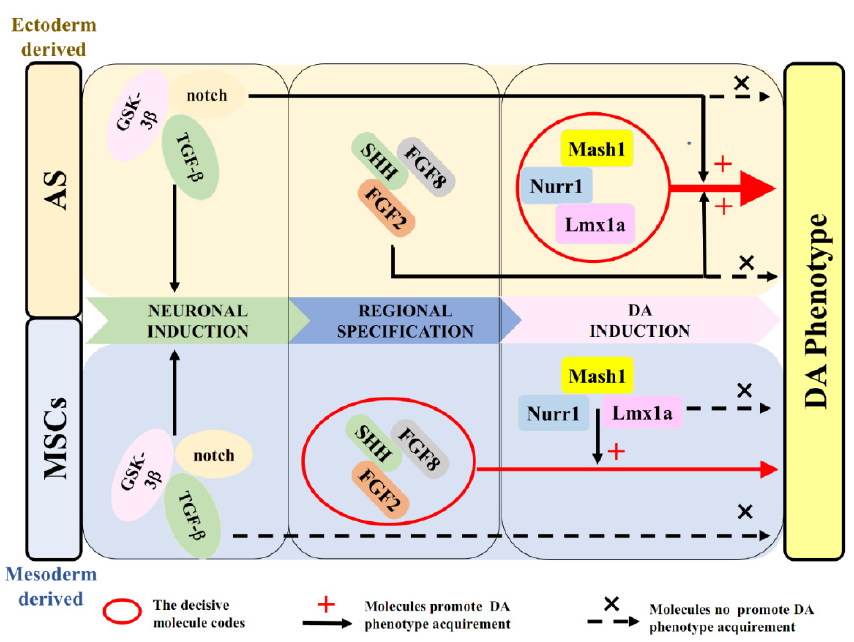
Figure 7. The differential decisive molecular code governing the DA phenotype acquirement of AS vs. MSCs. The diagram summarizes the sequential stages and possible key molecules involved in DA phenotype development from ectoderm- (AS) and mesoderm-derived (MSC) cells, respectively. Transcriptional regulation with Mash1, Nurr1, Lmx1a (MLN) plays a dominant role in the determi- nation of DA phenotype from AS; small molecules involved in TGF- β , GSK-3 β , and Notch pathways (SB431542, CHIR99021, and DAPT; S/C/D), as well as morphogens SHH, FGF2 and FGF8 (S/F8/F2), accelerate the efficiency of DA induction. In contrast, morphogens S/F8/F2 involved in DA regional specification are the key molecules for the DA phenotype acquirement from MSCs; Transcriptional cocktail MLN could promote the quality of DA phenotype derived from MSCs. Possible interactions between this network of molecules are indicated by arrows with solid lines. Molecules that do not promote DA phenotype acquirement are indicated by arrows with dashed lines. The decisive mo- lecular codes are indicated by red circles and arrows with solid lines.